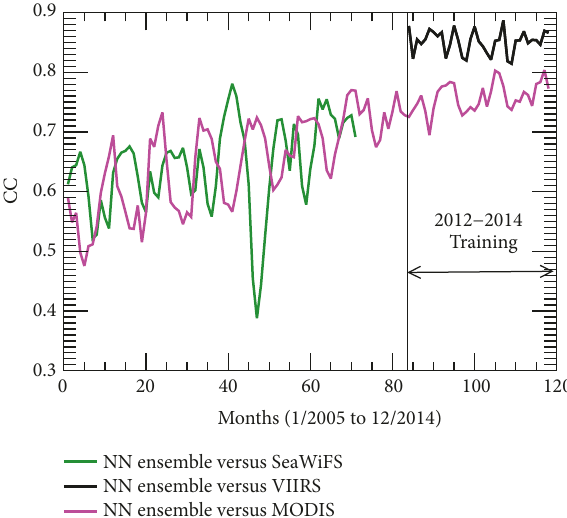
Figure 8: Bias of monthly mean chl-a concentrations simulated by NN ensemble versus VIIRS data (black curve), MODIS data (pink curve), and SeaWiFS data (green